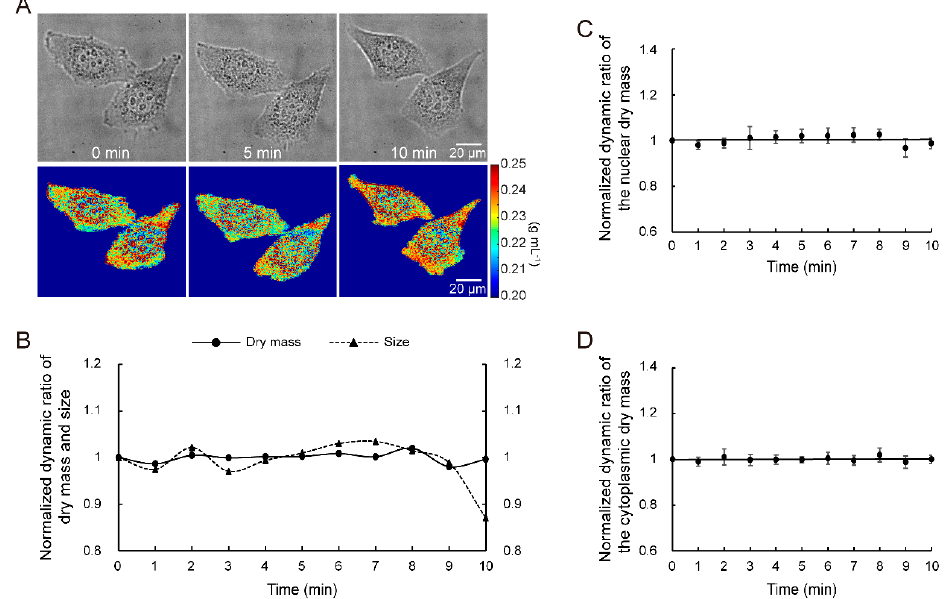
Figure 2. Quantitative dry mass measurement of live cells during osmotic pressure change. ( A ) Im- aging reconstruction of two living HeLa cells during osmotic pressure change. ( B ) Normalized dynamic ratio of dry mass and size for 200 living single cells. Normalized dynamic ratio of the nuclear ( C ) and cytoplasmic ( D ) dry mass for the 200 cells.